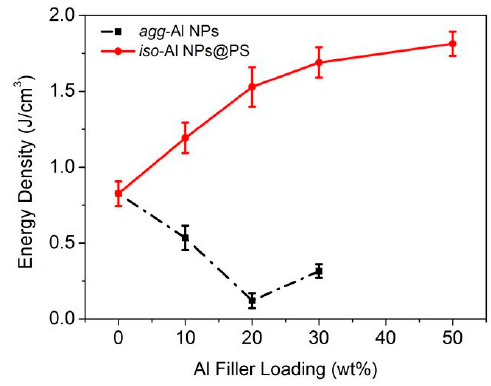
Figure 6. The calculated maximum energy storage density of the nanocomposite films doped with agg -Al NPs and iso -Al NPs@PS.